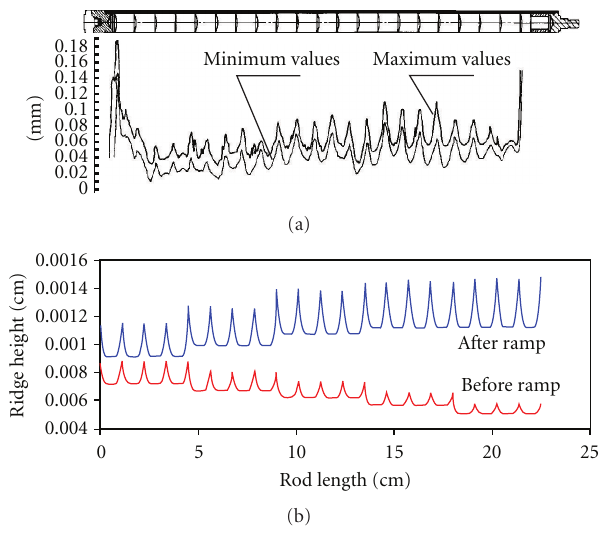
Figure 9: Fuel rod profile of the MOX fuel A.1.3 before and after the power ramp at EOL. (a) Experimental values after the power ramp. (b) Calculated values before and after